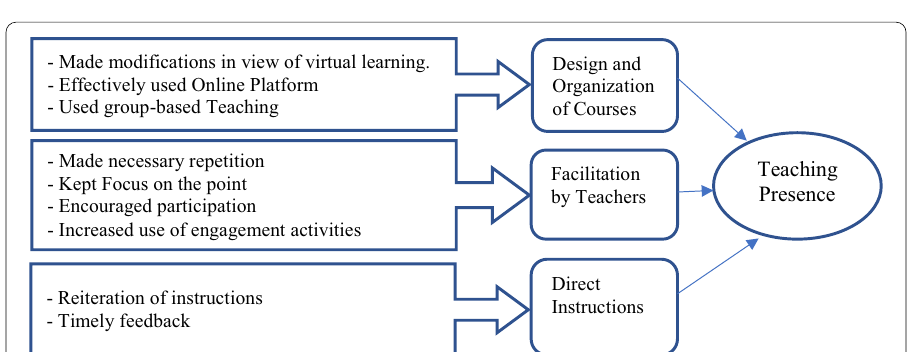
Fig. 1 Structure of students’ perceptions about teaching presence in virtual learning